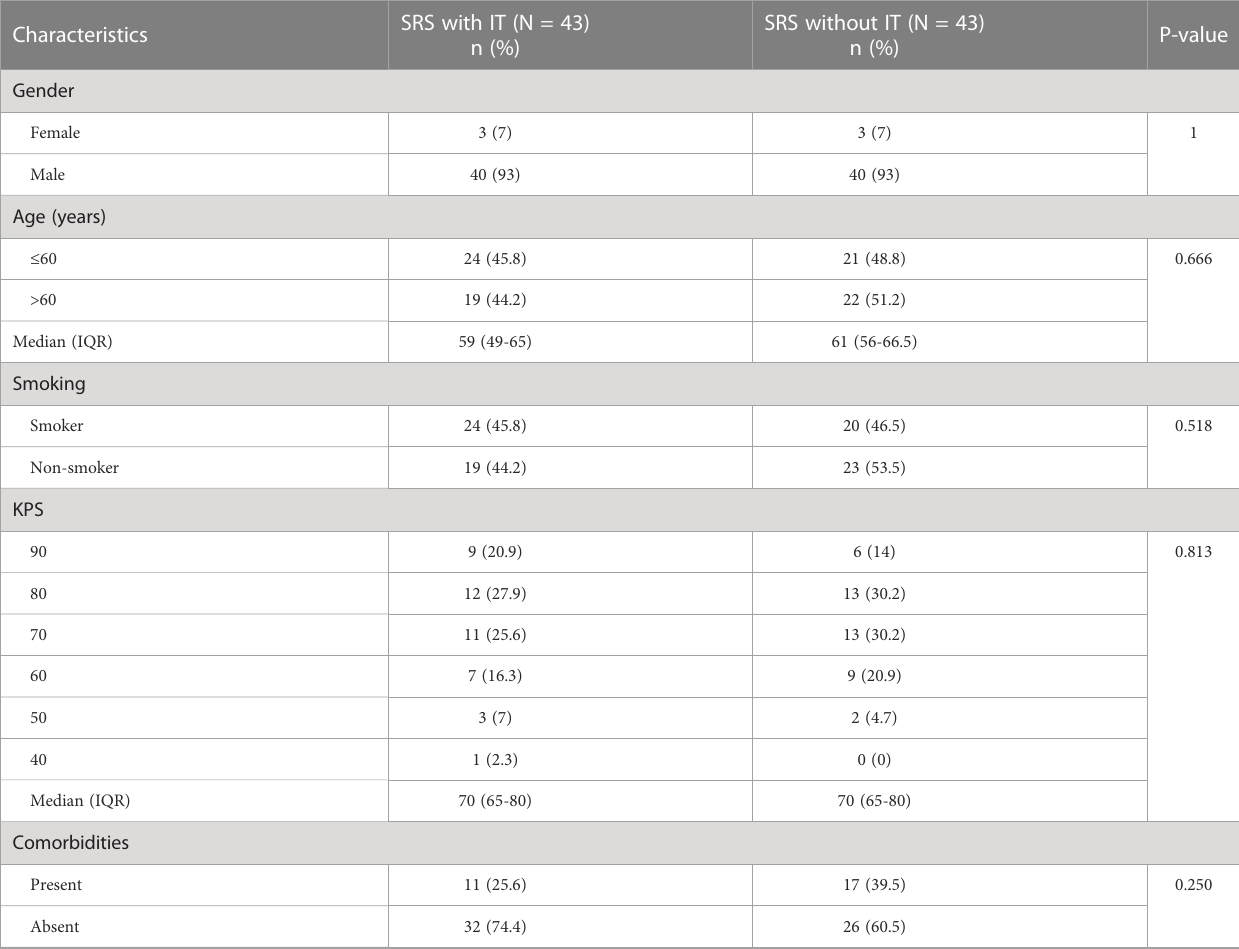
TABLE 1 Patients' baseline clinicodemographic